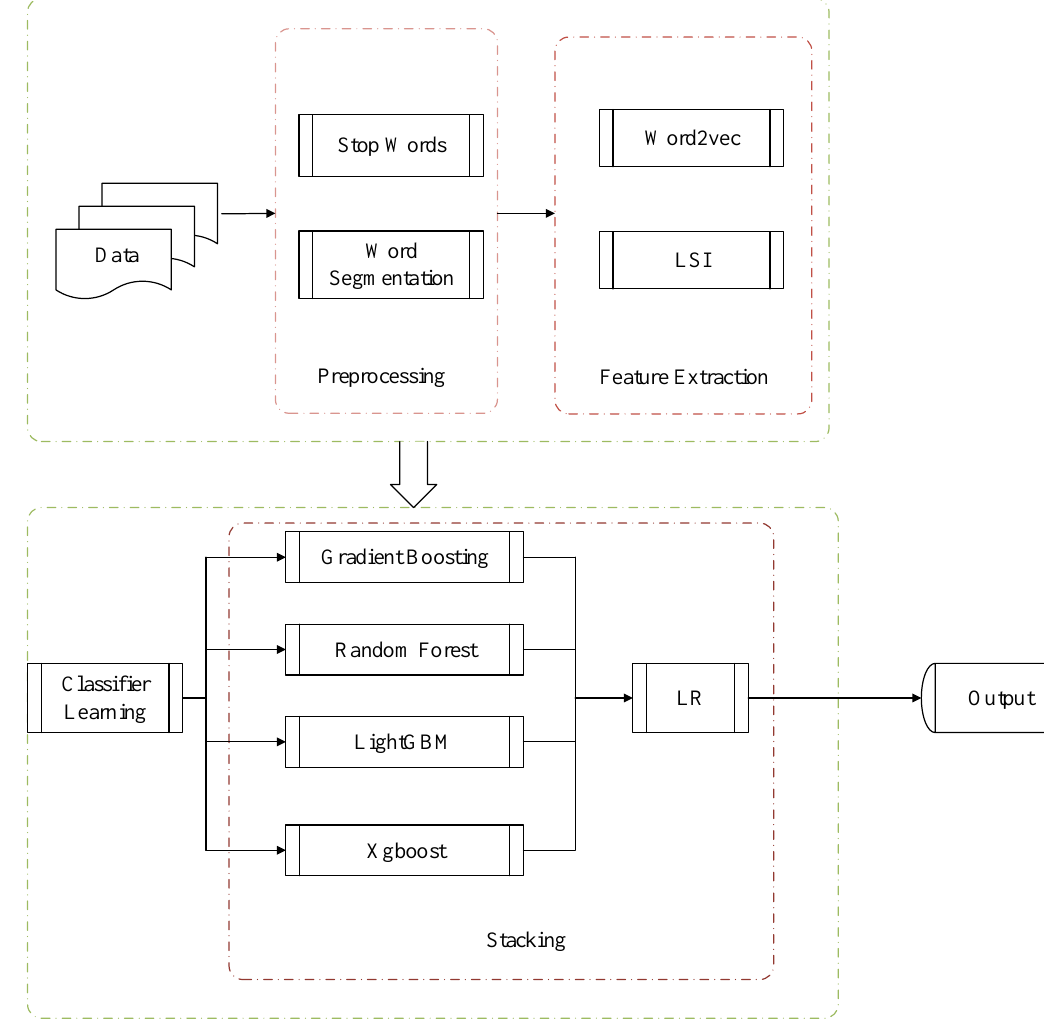
Figure 1. General architecture. LSI, Latent Semantic